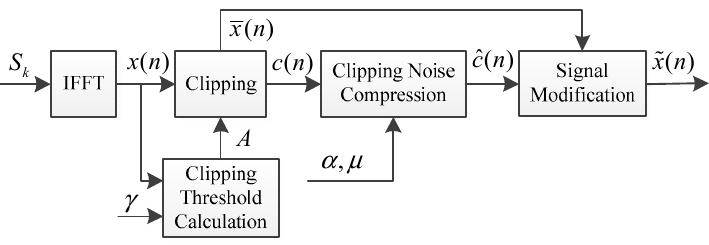
Figure 2. The simplified block diagram of the proposed method.